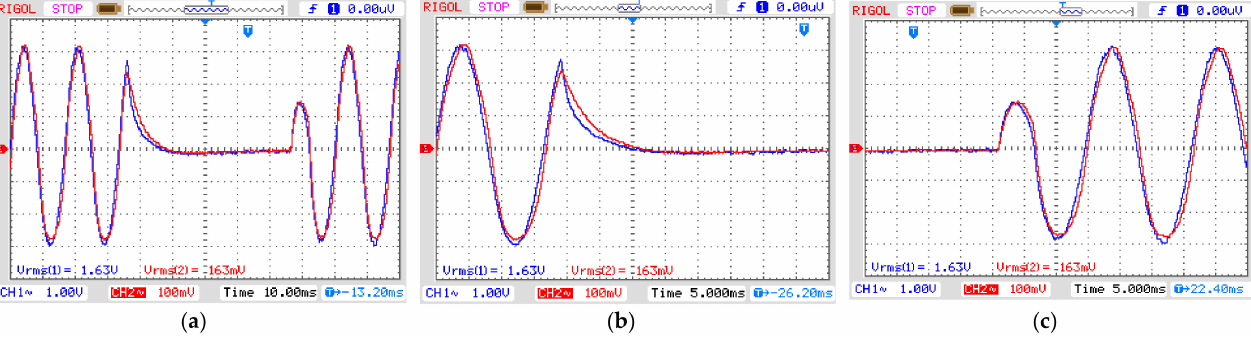
Figure 12. OVT input (CH1) and output (CH2) voltage for INTERRUPTION. Vertical axis: 1 V/div (CH1) and 100 mV/div (CH2). ( a ) Complete disturbance (horizontal axis: 10 ms/div); ( b ) Beginning of disturbance (horizontal axis: 5 ms/div); ( c ) End of disturbance (horizontal axis: 5